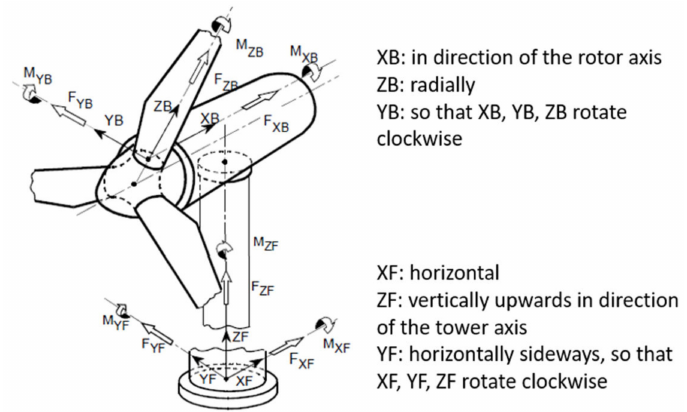
Figure 9. Blade and tower local coordinate system